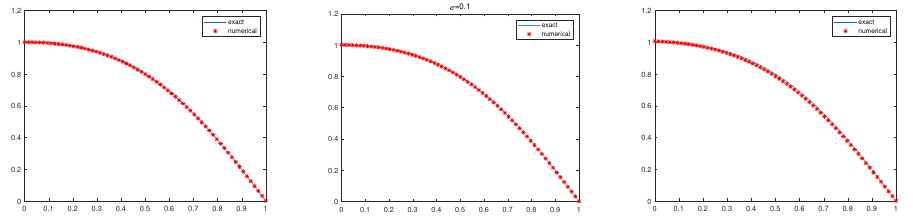
Figure 1. The exact solution and the numerical solutions (Left: σ = 0.05. Middle σ = 0.1. Right: σ = 0.2).